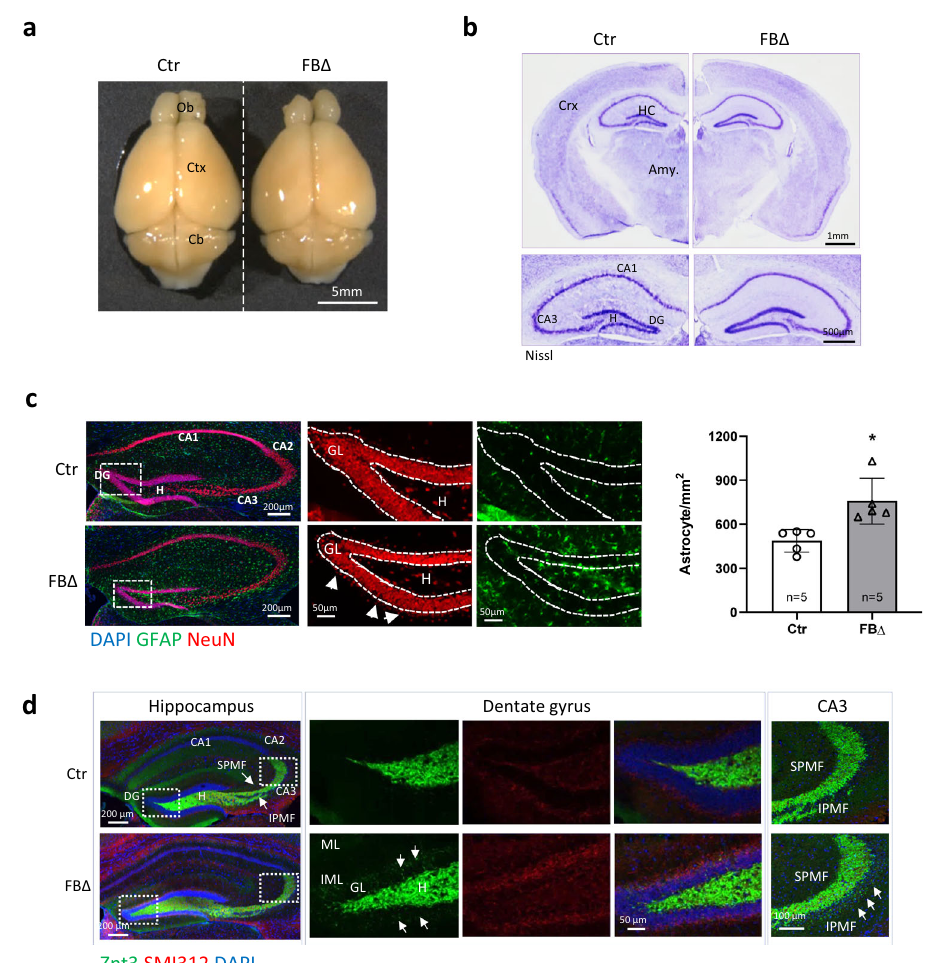
Fig. 3 ATR deletion in excitatory neurons of the mouse forebrain (ATR-FB Δ ) leads to developments of epileptic signs. a Dorsal views of the brains from 3-month-old control (Ctr) and ATR-FB Δ (FB Δ ) mice. Ob Olfactory Bulb, Ctx Cortex, Cb Cerebellum. b Coronal brain sections of 3-month-old control and ATR-FB Δ brains were stained with Nissl. The upper panel shows the complete half hemisphere and the lower panel displays the magni fi ed images of the hippocampal regions. The images are representative from 3 to 4 mice per genotype analyzed. Ctx Cortex, HC Hippocampus, Amy. Amygdala, DG Dentate Gyrus, CA Cornu Ammonis, H Hilus. c Hippocampal astrogliosis in ATR-FB Δ mice. Coronal sections from control and ATR-FB Δ littermates at 10 – 12 months old after epileptic seizures were stained with DAPI, GFAP and NeuN to label nuclei, astrocytes and post-mitotic neurons, respectively. Right panels show magni fi cations of the dentate gyrus. Neurons are leaving the dentate gyrus (arrows) and expression of GFAP is markedly increased. CA Cornu Ammonis, DG Dentate Gyrus, H Hilus, GL Granular Layer. The graph shows the quanti fi cation of GFAP-positive cells within the hippocampal area from at least 2 – 3 sections per animal. The number of mice used is indicated within the bar. Data are presented as mean values of ± SD. Student ’ s t -test (unpaired, two- tailed). p = 0.013. * p < 0.05. d Mossy fi ber sprouting in the hippocampus of 10-month-old epileptic ATR-FB Δ mice. Coronal sections of brains were stained with DAPI, ZnT-3 and SMI312 antibodies to label nuclei, mossy fi bers and axonal neuro fi laments, respectively. White arrows indicate the mossy fi ber sprouting in IML. Neuro fi laments follow the same pattern of ZnT-3 staining. The magni fi ed images of the white rectangles on the DG and CA3 areas are shown in the right panels. The images are representative from 3 mice per genotype analyzed. CA Cornu Ammonis, DG Dentate Gyrus, SPMF Suprapyramidal Mossy Fibers, IPMF Infrapyramidal Mossy Fibers, H Hilus, GL Granular Layer, ML Molecular Layer, IML Inner Molecular Layer. Source data are provided as a Source Data fi